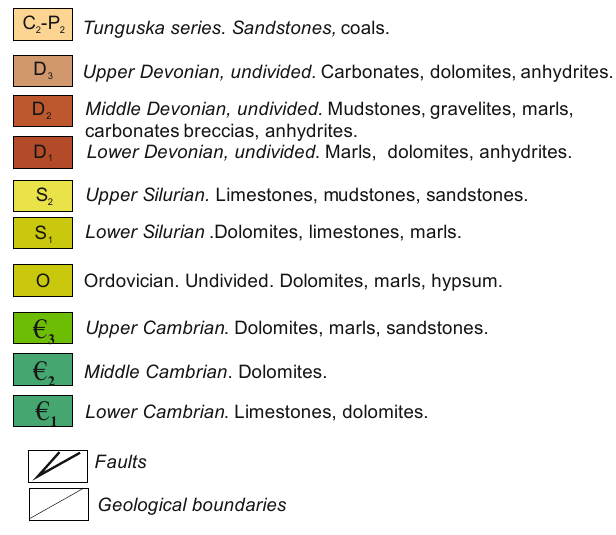
the Permian Period.